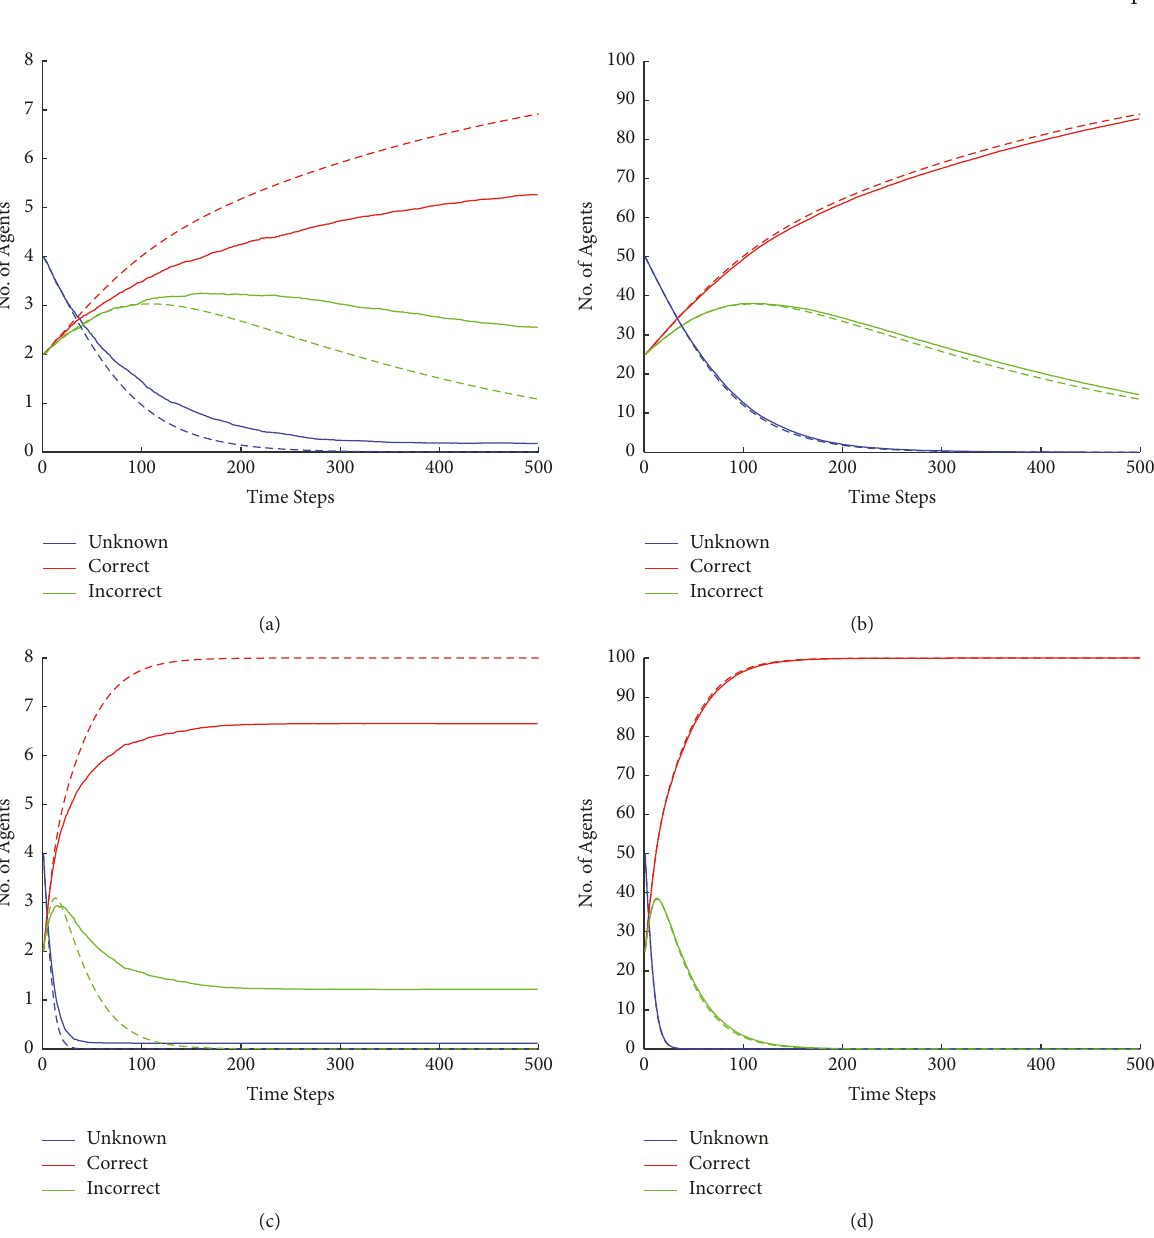
Figure 3: Dynamics in “nominal” scenario against low and high trust values with different population sizes. (a) Trust = 0.1, population size = 8; (b) trust = 0.1, population size = 100; (c) trust = 0.9, population size = 8; (d) trust = 0.9, population size = 100.